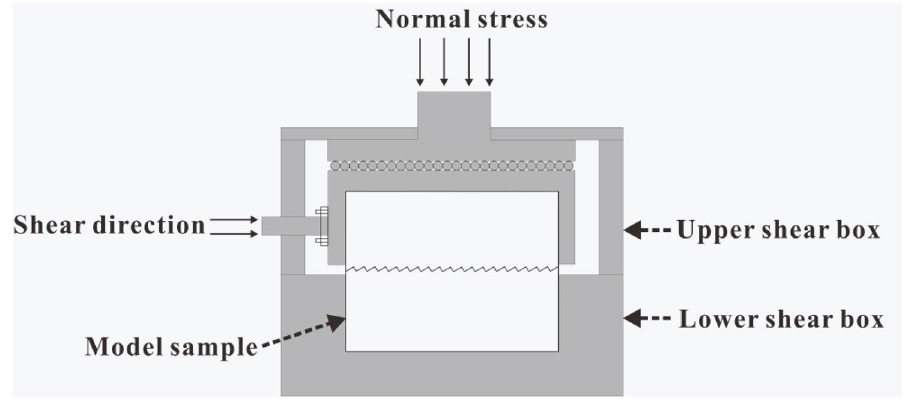
Figure 15. Shear box